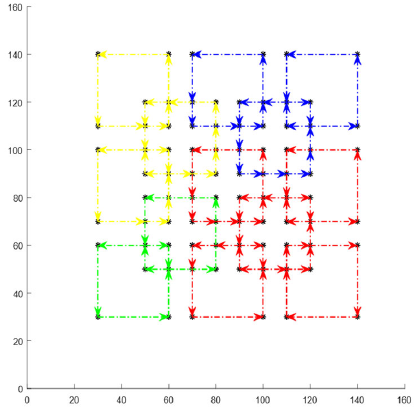
Figure 5. Partitions found in the geometric model.